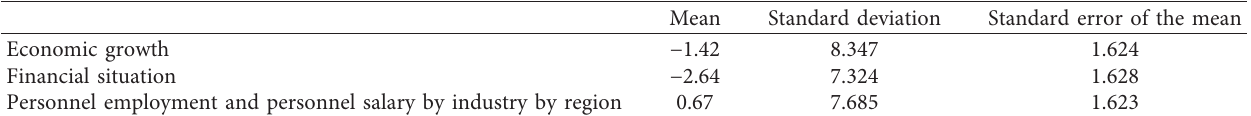
Table 8: Judgement table for the relevance of evaluation